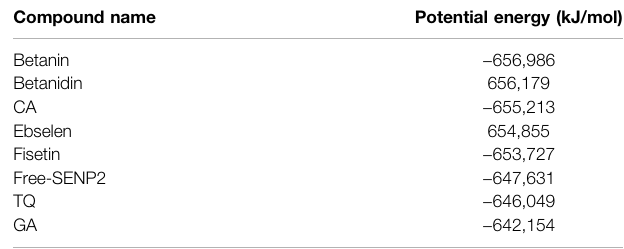
TABLE3| BindingenergyofMDsimulationforcompounds:GA,CA,TQ,Betanin, Betanidin, Ebselen, and Fisetin.